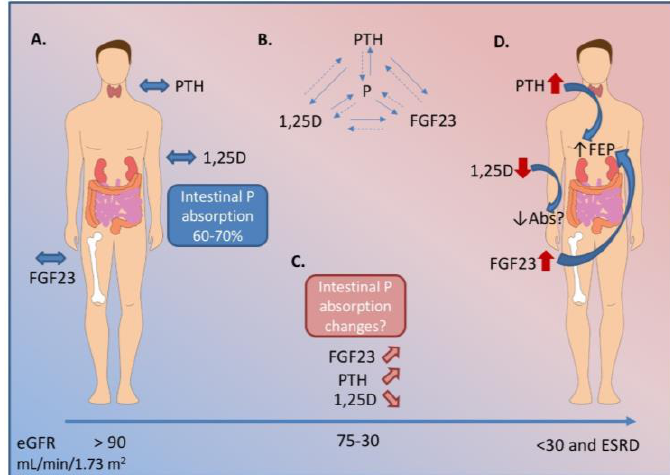
Figure 1. Biochemical changes in hormonal regulators of P (phosphorus) throughout the course of chronic kidney disease (CKD). A. In health, fibroblast growth factor 23 (FGF23) from osteocytes, parathyroid hormone (PTH) from the parathyroid gland, and 1,25-dihyxdroxyvitamin D (1,25D) work together to keep serum P within a tight range. A healthy person absorbs 60 – 70% of P in a mixed diet. B. PTH, 1,25D, and FGF23 also regulate each other in a series of feedback loops. C. As renal decline progresses, the kidney loses its ability to excrete excess P. FGF23 begins to rise earlier in the disease course, followed by a decline in 1,25D, and a rise in PTH. D. In end stage renal disease, the hormonal regulation is unable to maintain serum P within an normal range. At this stage, patients have very high FGF23, PTH, and low 1,25D. The biochemical profile in early and moderate stage CKD indicate intestinal P absorption should be decreased. However, literature suggests P absorption may be inappropriately maintained and, therefore, contributes to overall P burden in CKD. Dashed lines indicate negative feedback. Abs indicates intestinal P absorption; FEP indicates fractional excretion of P from the kidney; eGFR indicates estimated glomerular filtration rate. ESRD indicates end stage renal disease.